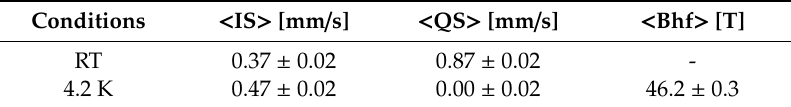
Figure 11. Low temperature Mössbauer spectrum of the EC solid product prepared from leachate of EAFS. Table 4. Hyperfine parameters of the sample EAFS.